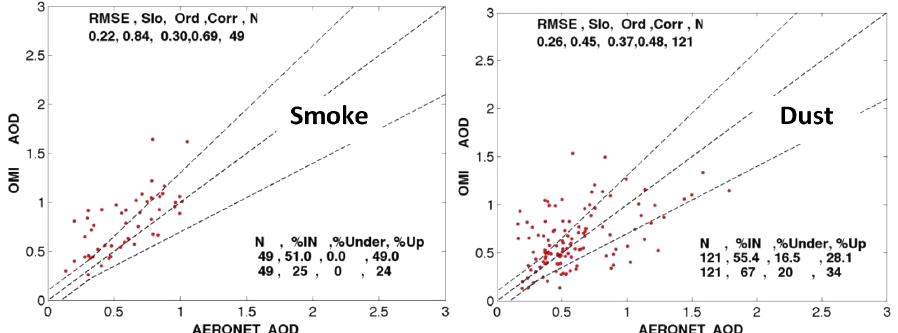
Figure 3. OMI vs. AERONET AOD 380nm. Same data points and statistics from Fig. 2b but segregated by aerosol type as determined by the OMAERUV algorithm and screened by number of successful OMI retrievals surrounding the comparison pixels (only pixels with eight successful retrievals around the selected pixel are used in the comparison).